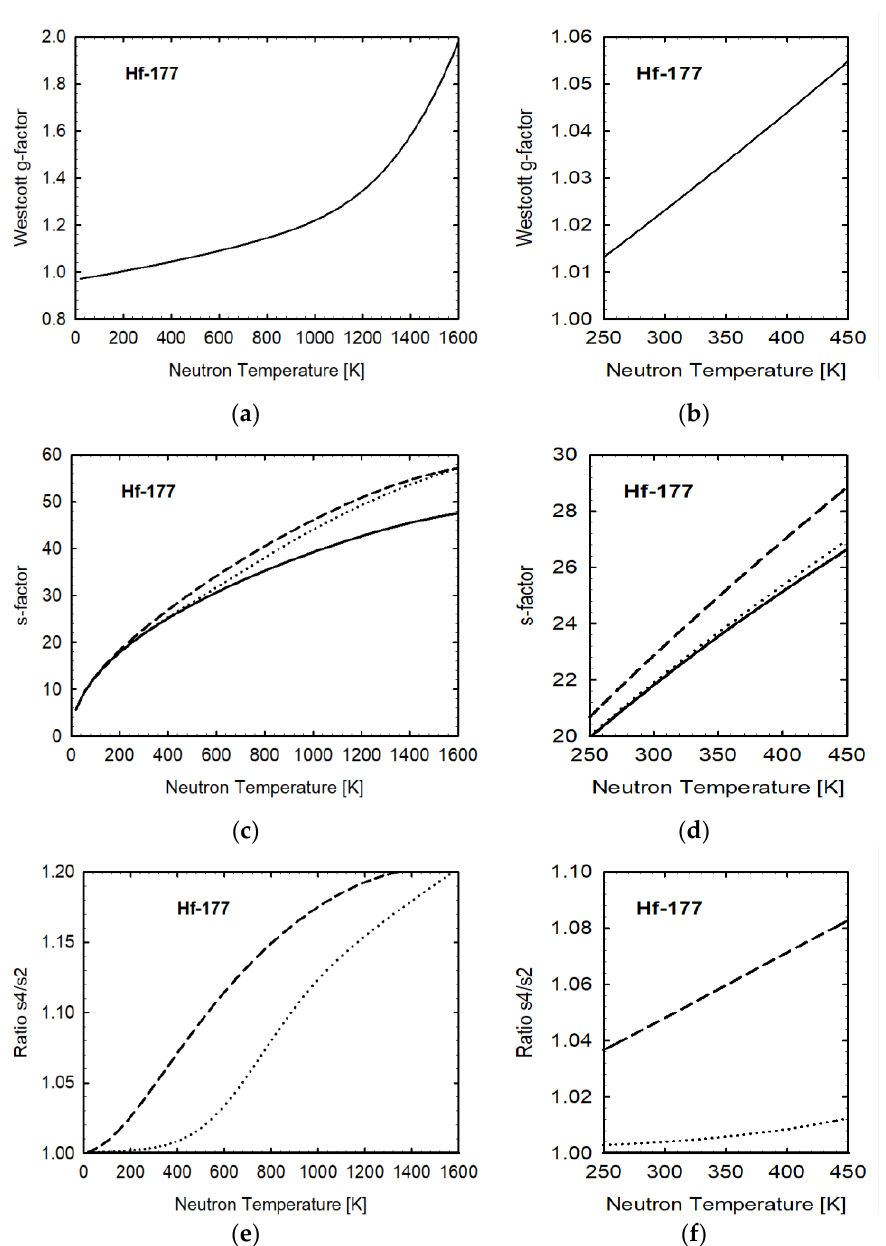
Figure 12. ( a ) Westcott g-factor for 177 Hf as a function of neutron temperature 𝑇 𝑛 ; ( b ) Expanded figure of ( a ); ( c ) s-factors, s 2𝑊 (solid line), s 4𝑊 (dotted line), s 4𝐻 (dashed line) for 177 Hf as a function of neutron temperature 𝑇 𝑛 ; ( d ) Expanded figure of ( c ); ( e ) Ratios of s-factors, s 4𝑊 /s 2𝑊 (dotted line) and s 4𝐻 /s 2𝑊 (dashed line) for 177 Hf; ( f ) Expanded figure of ( e ).